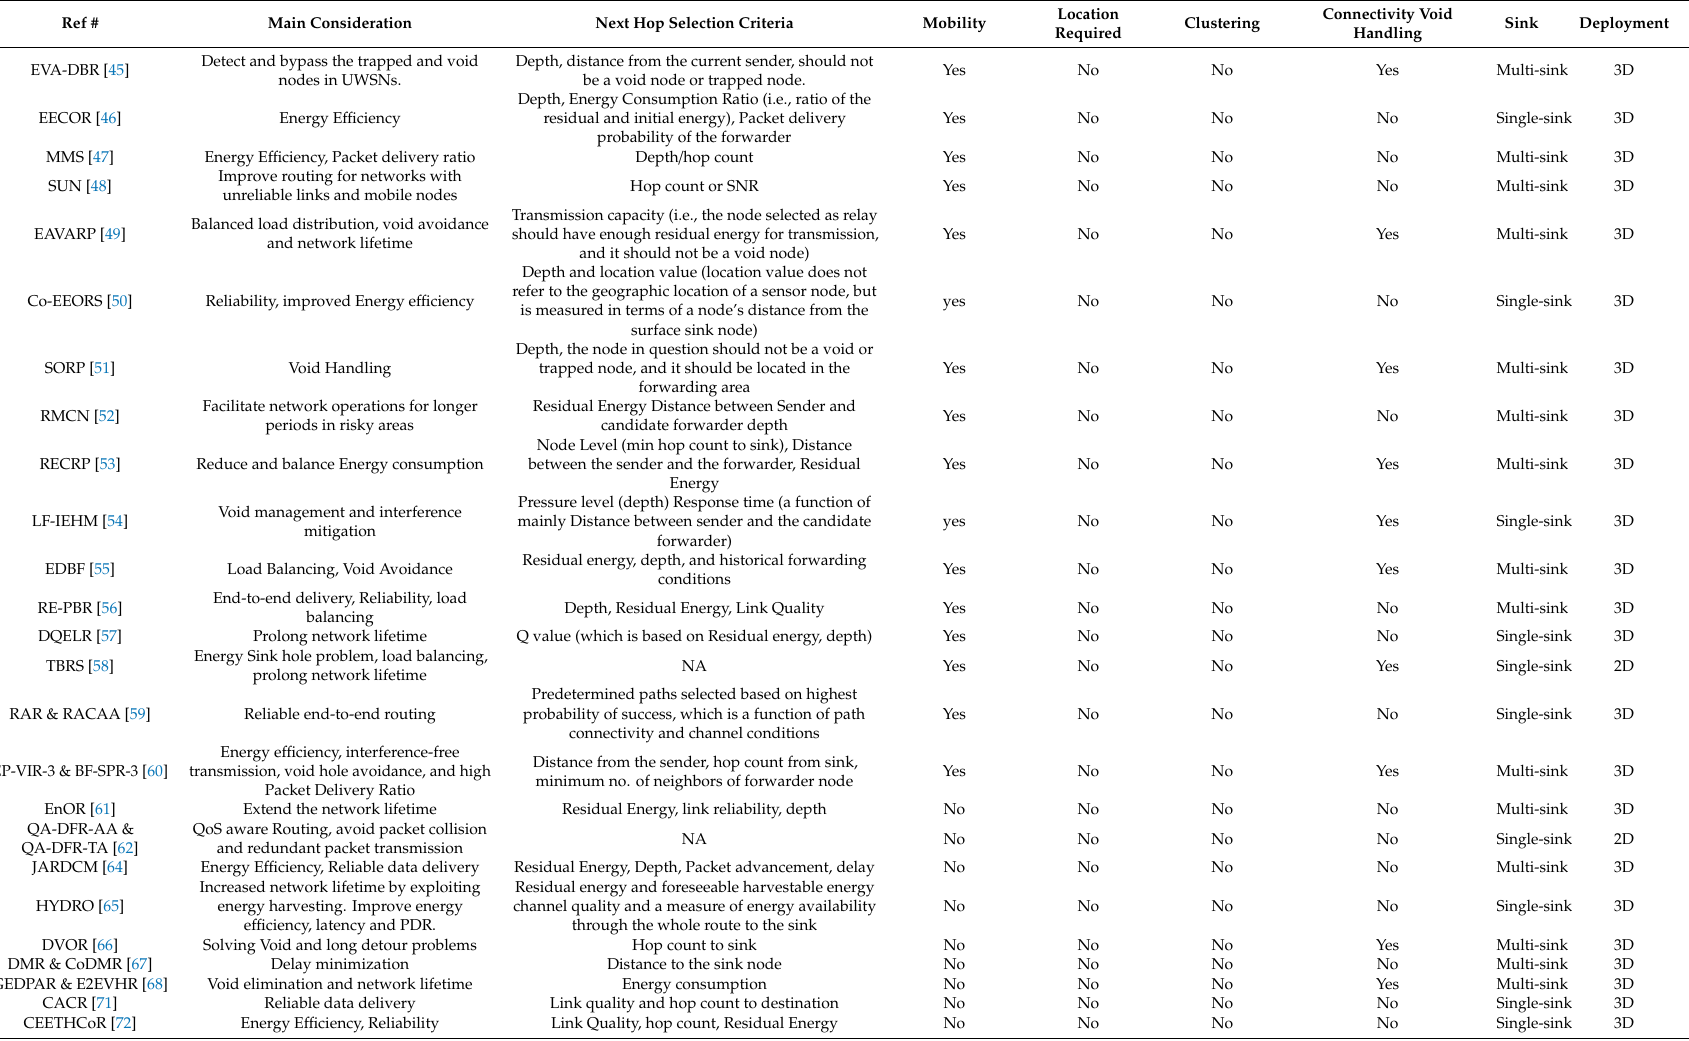
Table 2. Survey of localization-free routing